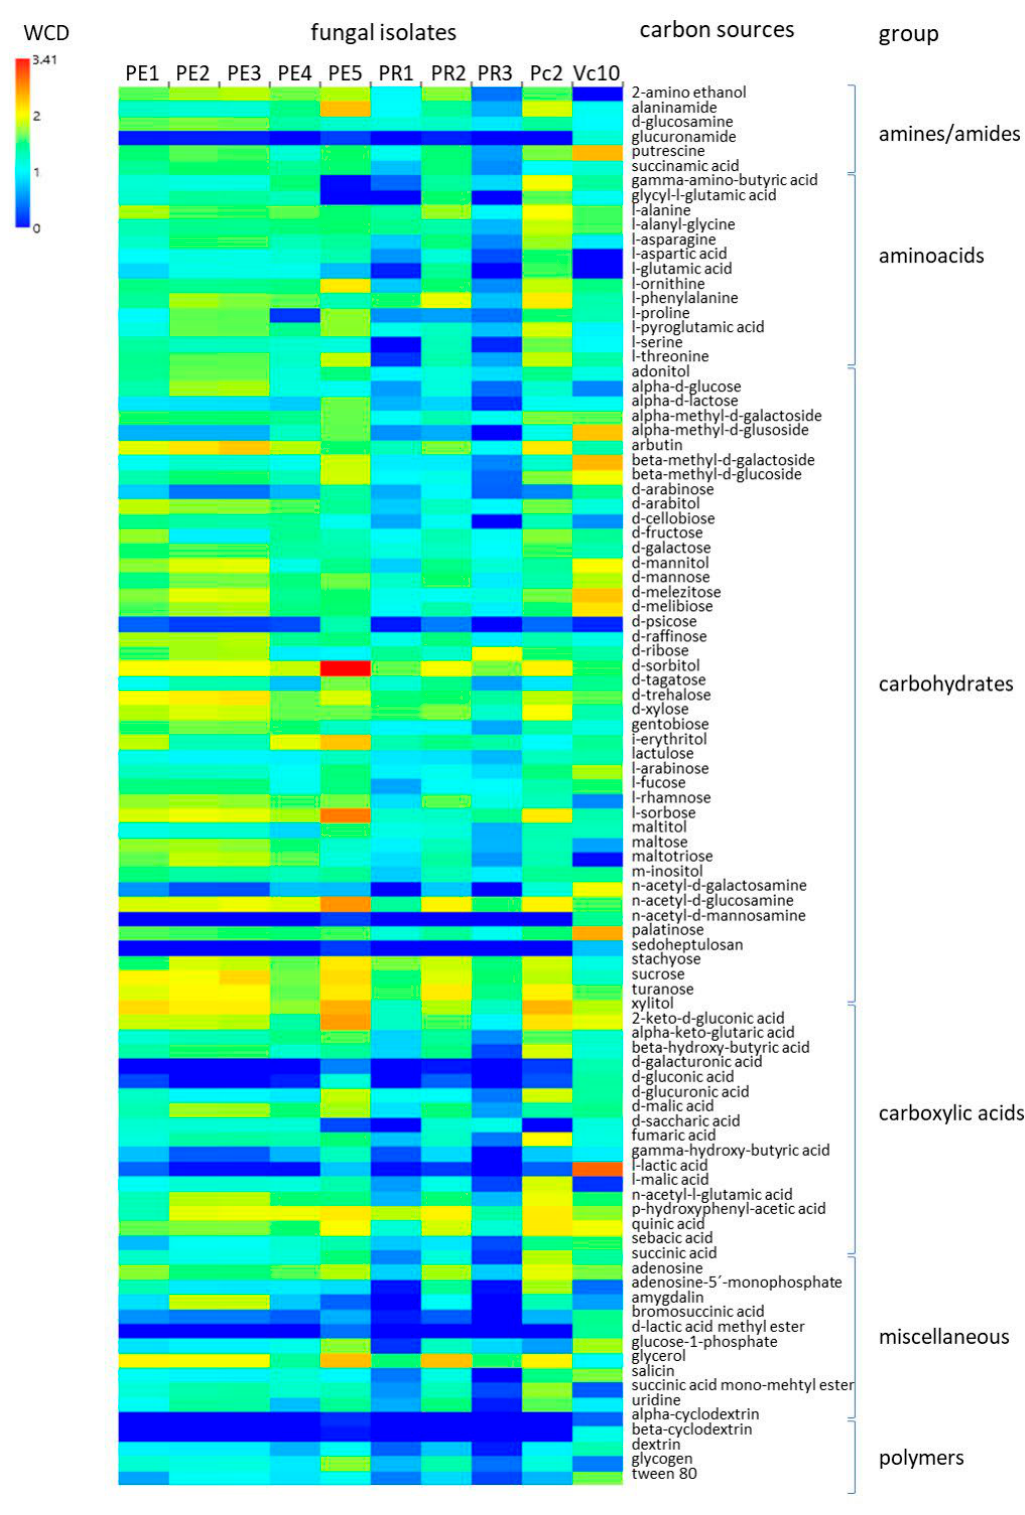
Figure 5. Heat map of carbon source utilisation by Pochonia chlamydosporia isolates (PE1, PE2, PE3, PE4, PE5, PR1, PR2, PR3, Pc2 and Vc10; refer to Table 1 for isolate information), assessed through Well Colour Development (WCD) at 7 d, corrected to control, of each of 95 carbon sources/chemical group, using Biolog FF